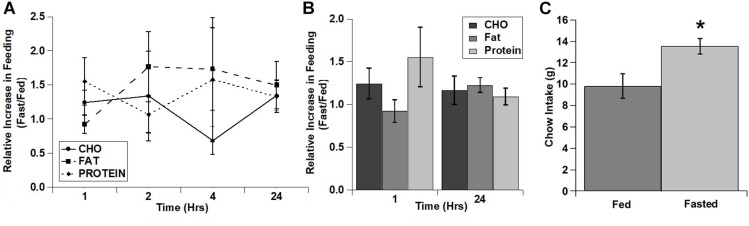
Fasting increased the intake of all three test diets to a similar extent and increased post-test home cage chow intake. (A) Relative increase in intake in response to fasting during each individual time period (Non-cumulative). (B) Relative increase in cumulative intake in response to fasting at 1 and 24 h post-injection. (C) Post-test, 24 h home cage chow intake. n = 8–12 (A,B). n = 12 (C). *p = 0.007.